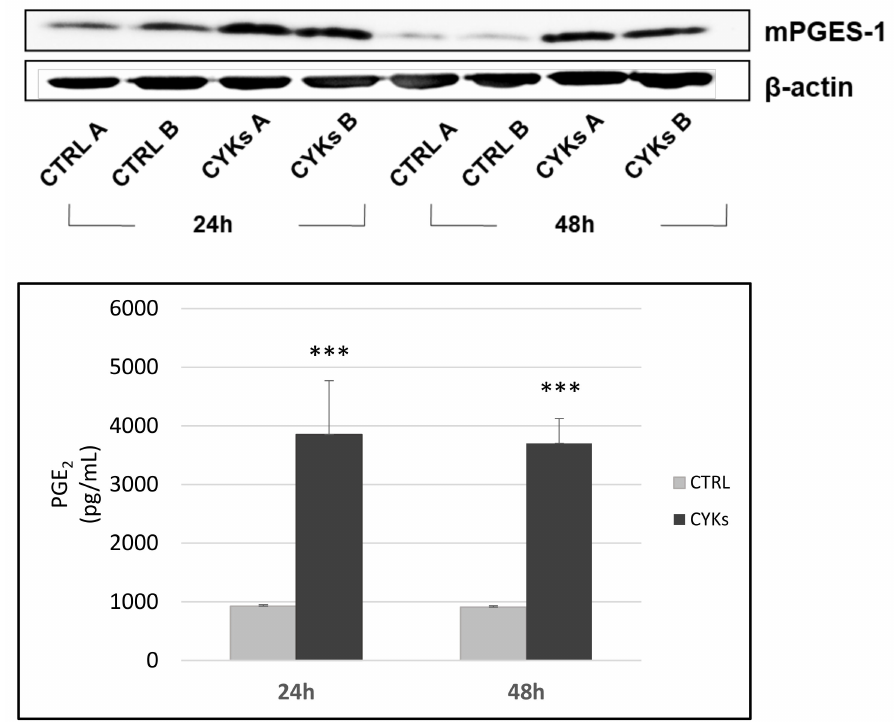
Figure 1. Development of an inflammation model on normal human dermal fibroblast (NHDF) cells. Fibroblasts were treated with IL-1 β (10 ng/mL) + TNF- α (10 ng/mL) for 24 h and 48 h. Whole cell lysates were collected to assess mPGES-1 expression by Western blot (upper panel). Samples A and B represent intra-experimental duplicates. The measurement of PGE-2 performed by immunoenzymatic assay is reported (lower panel). At both times, there is an upregulation of the prostanoid system. Data represent means +/ − SD ( n = 3) *** p < 0.001 CYKs group vs. CTRL